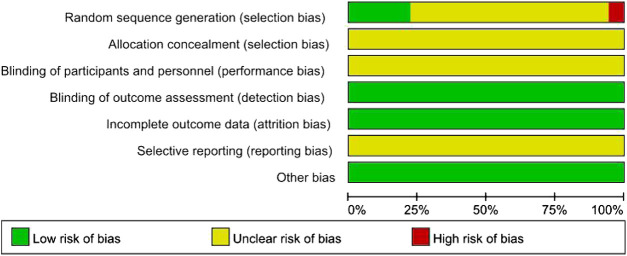
Risk-of-bias graph.